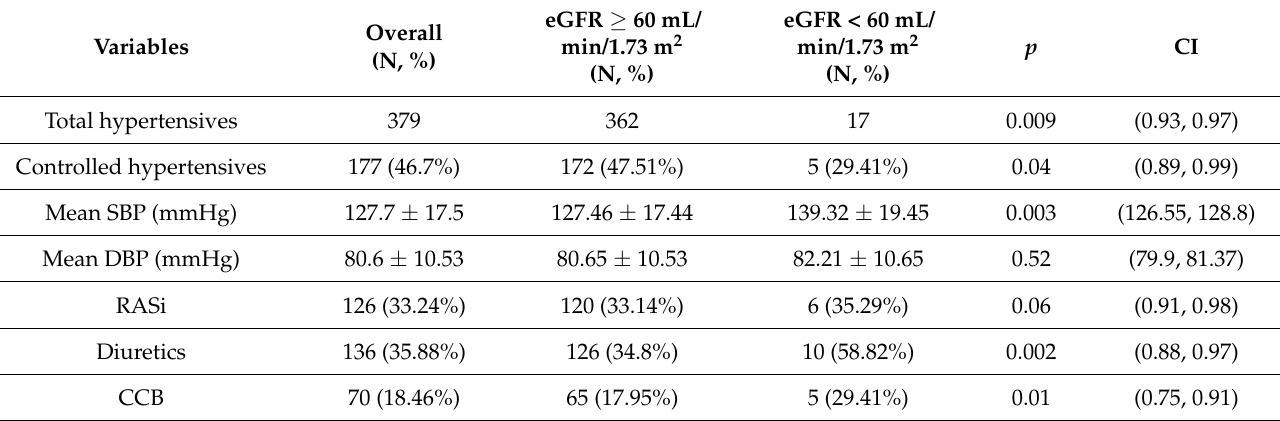
Table 3. Blood pressure and exposure to drugs in the hypertensive subjects according to eGFR CKD-EPI ≥ 60 or <60 mL/min/1.73 m 2 . LEGEND: eGFR—estimated glomerular